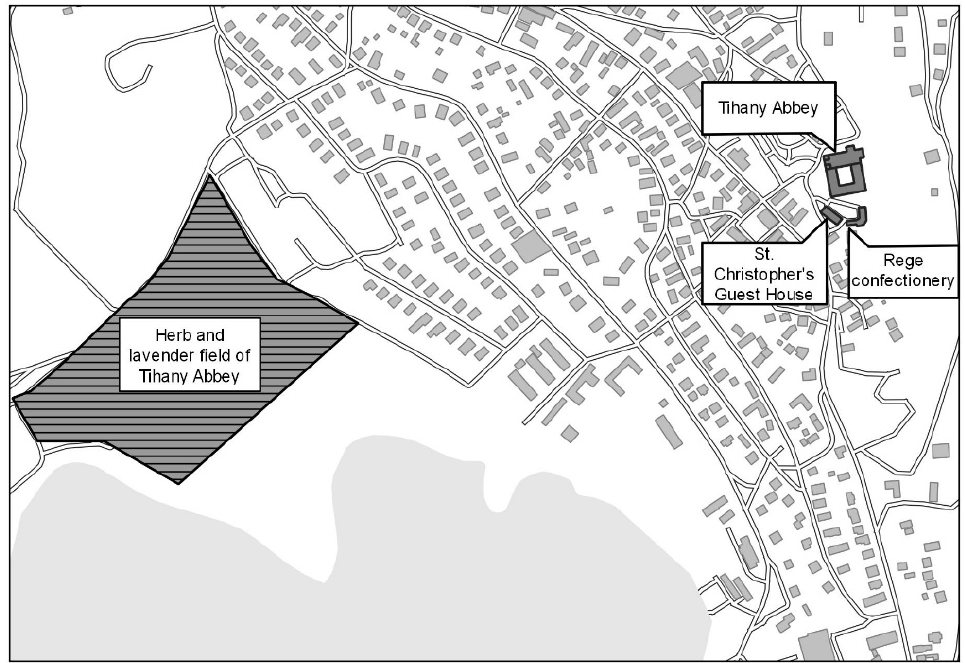
Figure 6. The touristic attractions and economic units of the Benedictine monks of Tihany. Source: Own